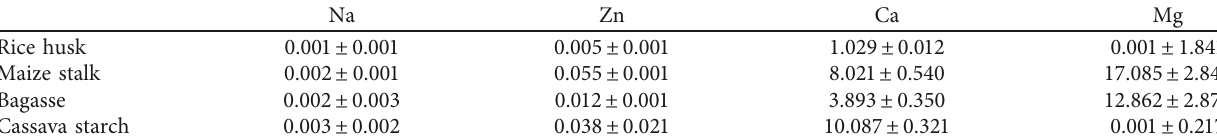
Figure 5: Thickness swelling (TS) of the Table 2: Chemical analysis for lignocellulose materials and cassava starch.